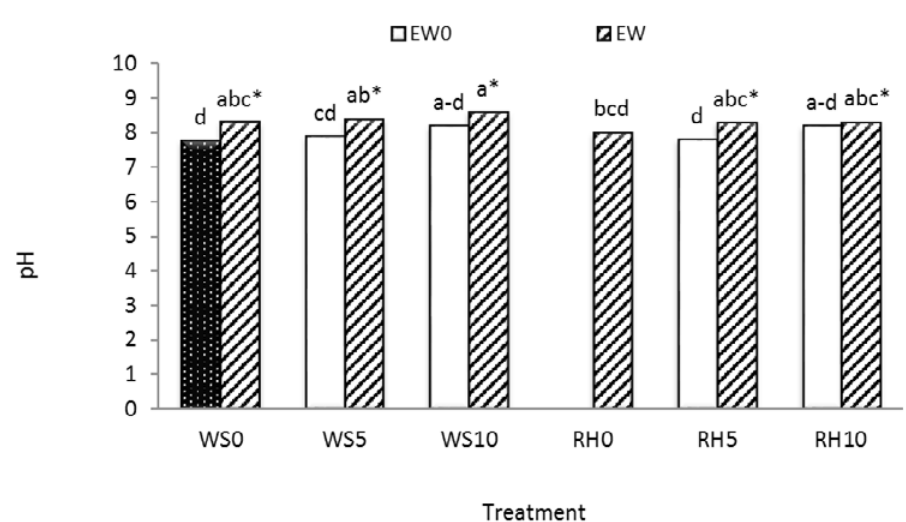
Figure 2. Effects of the treatments on the wastewater pH EW0: without vermicomposting; EW: with vermicomposting; WS0: without wheat straw; WS5: 5% v/v wheat straw; WS10 10% v/v wheat straw; RH0 without rice husk; RH5: 5% v/v rice husk; RH10: 10% v/v rice husk. Means in the same column followed by the same letter are not significantly different according to DMRT at (P≤0.05).